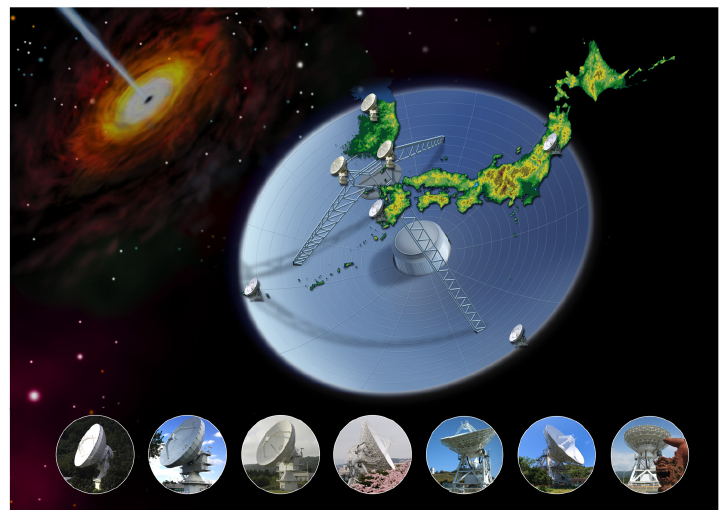
Figure 3. The KVN and VERA Array. From the left corner, the pictures of telescopes are Yonsei, Ulsan, Tamna, Mizusawa, Iriki, Ogasawara, and Ishigaki,